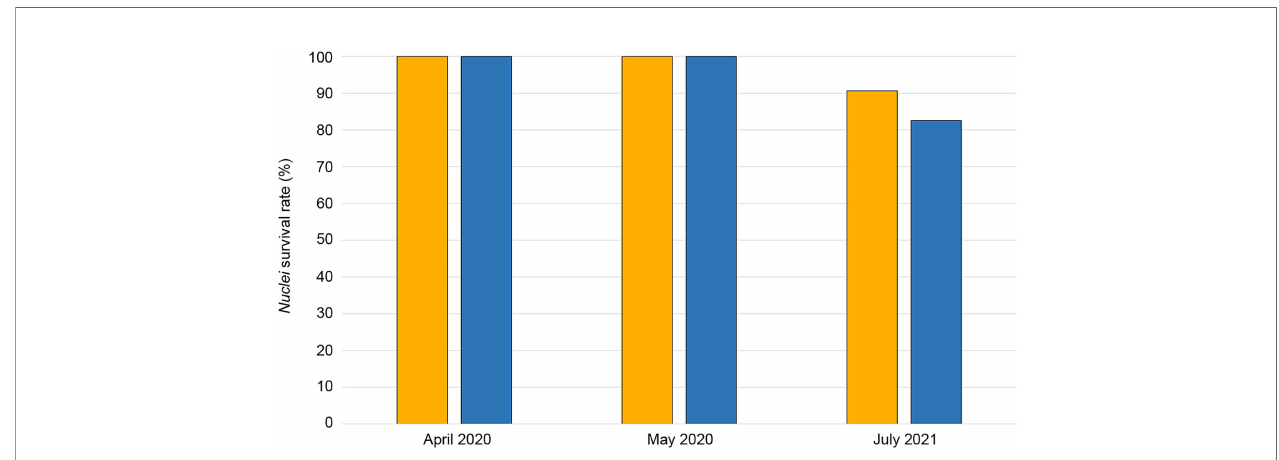
FIGURE 7 | Survival rate (expressed as a percentage of the total number of nuclei relocated) of the transplanted nuclei measured at the end (April 2020), one month after (May 2020), and fourteen months after (July 2021) the relocation activities. Bars color refers to the depth layers: orange for B (50-69 m), and blue for C (70-80) (same tones applied in Figure 3 ).